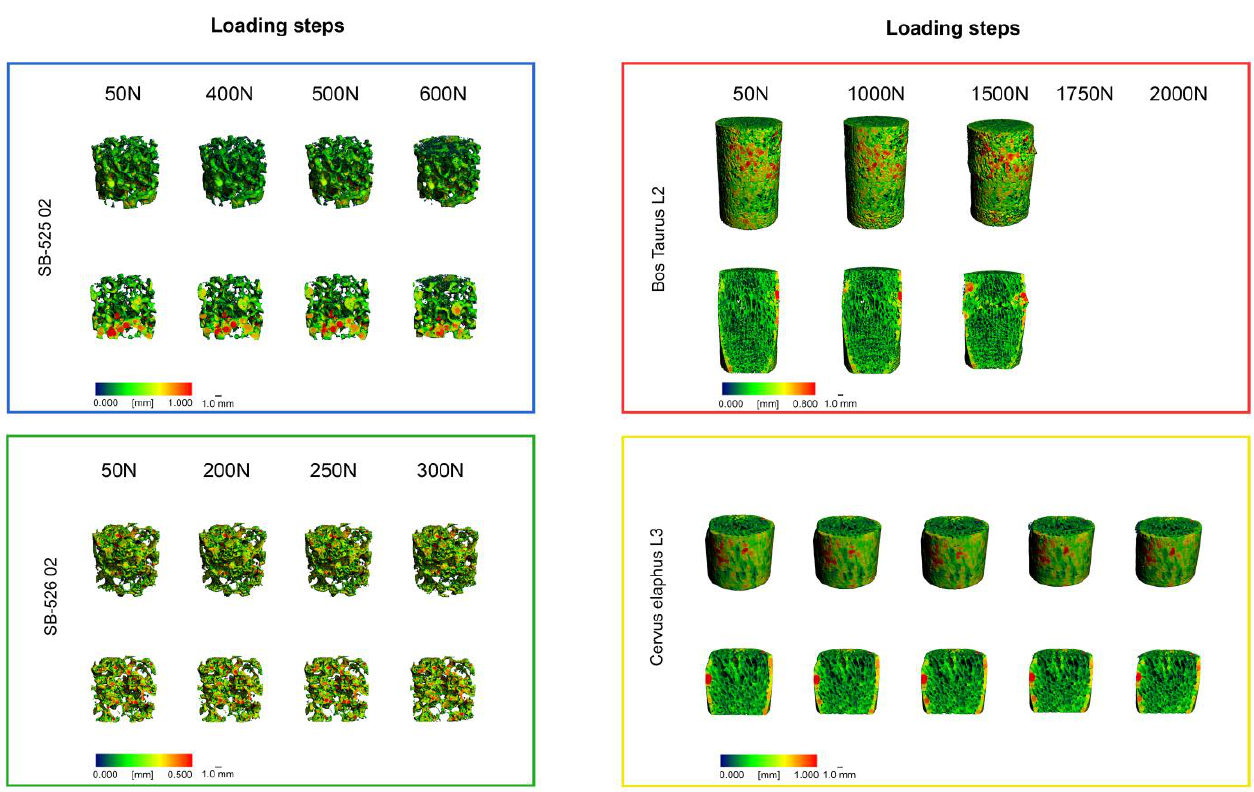
Figure 5. 3D rendering of pQCT scans of each specimen dataset without and with cross-section for spatial thickness distribution (0.000 – 0.800 mm).